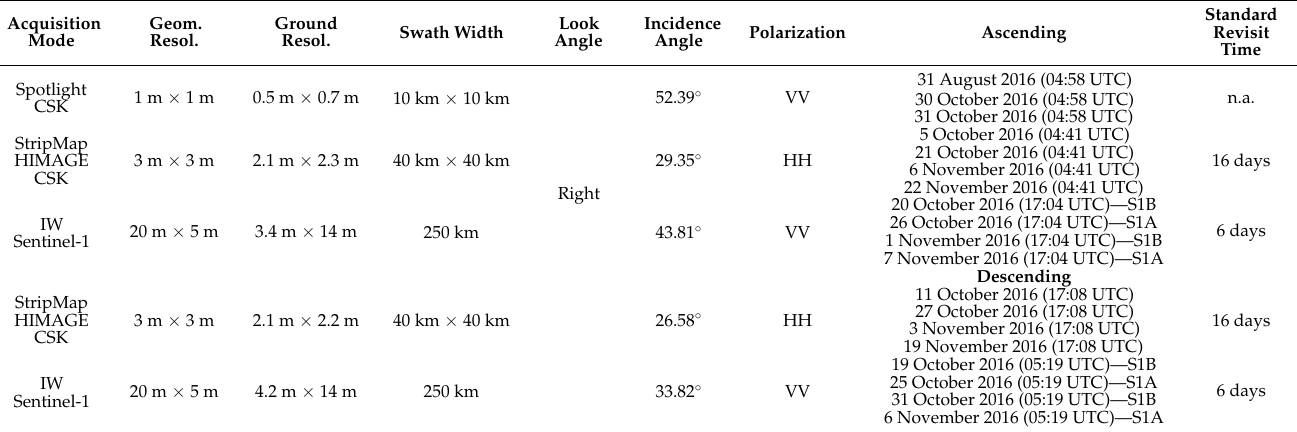
Table 1. Description of the analyzed dataset (dates are in dd/mm/yyyy hh:mm UTC). The SAR images for each dataset have been acquired with the same acquisition condition and geometry.